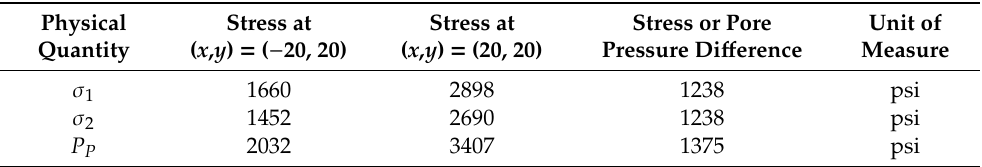
Table 4. Principal stress magnitude comparison at directly opposite coordinate for variable pore pressure.